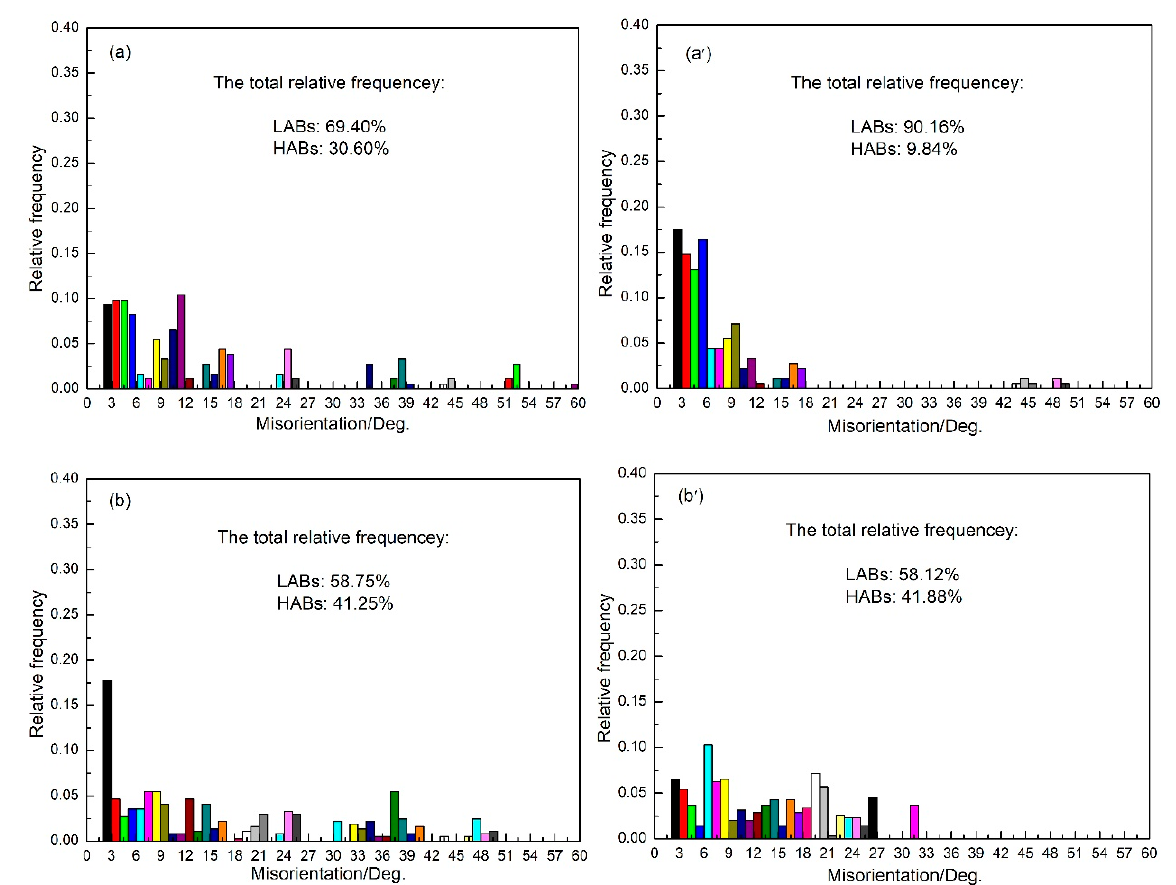
Figure 10. Misorientation distribution of the β grain boundary in BZ ( left figures ) and VBZ ( right figures ) at different times: ( a , a ′ ) 1 min; ( b , b ′ ) 10 min. Table 3. Average misorientation of the α and β grain boundaries in BZ and VBZ.